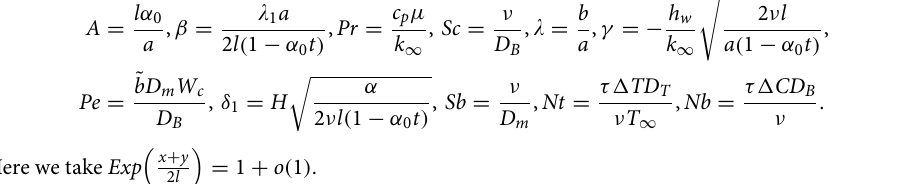
Here we take Exp